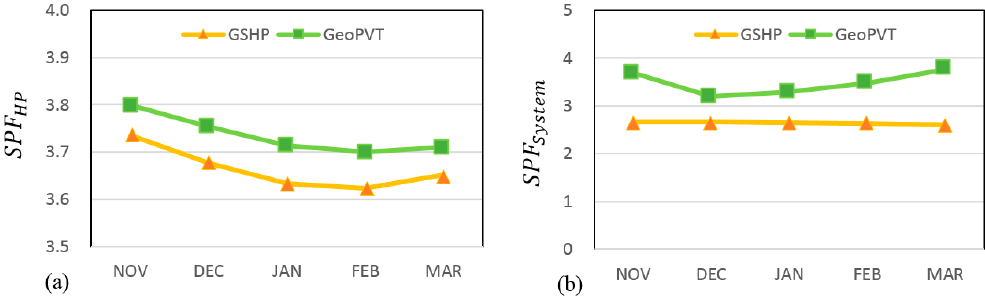
Figure 23. The result of SPF during 24 h operation in heating season. ( a ) Heat pump; ( b ) system.